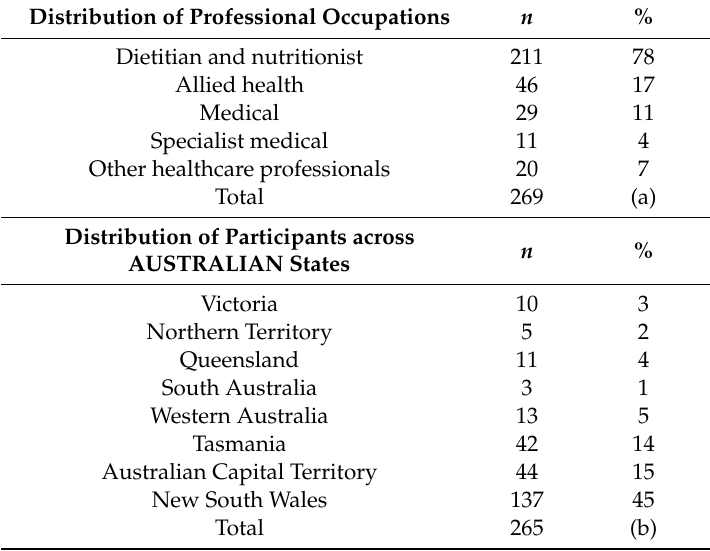
Table 1. Survey participant